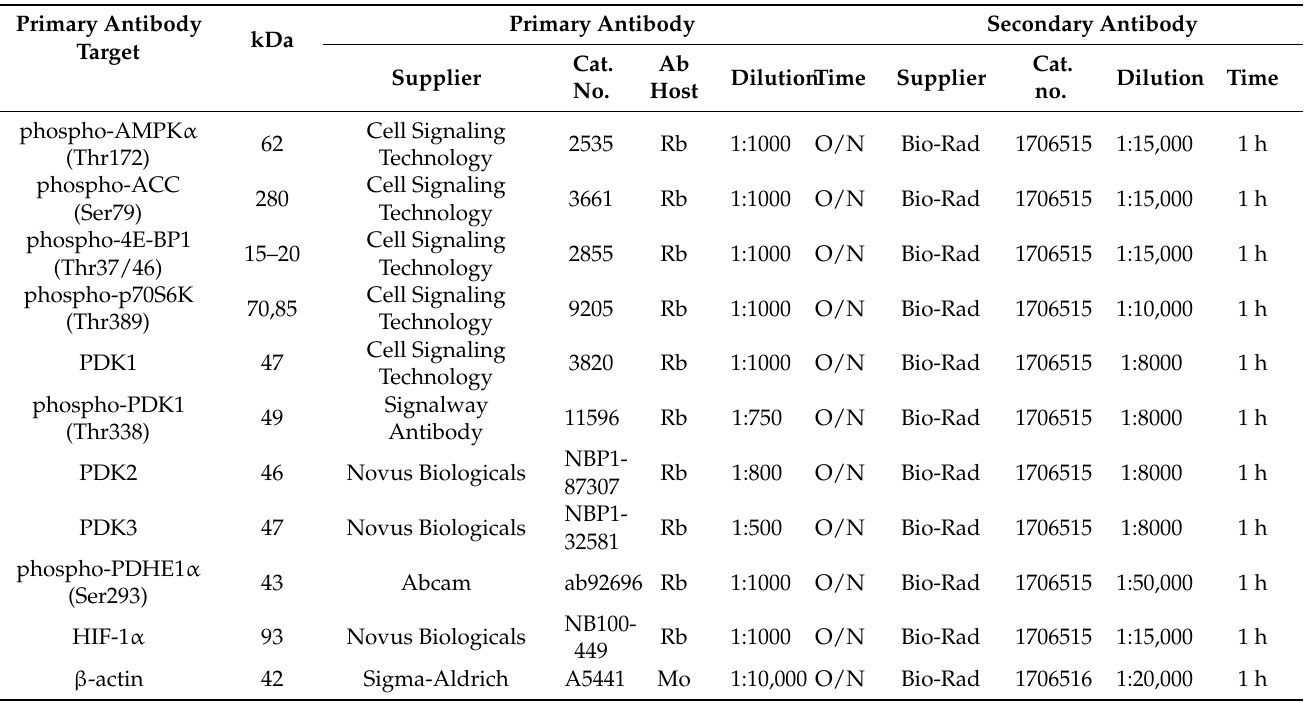
Table 1. Overview of the antibodies used for immunoblotting. Abbreviations: Ab—antibody, Mo—mouse, O/N—overnight, Rb— rabbit. Cell Signaling Technology (Danvers, MA, USA), Novus Biologicals (Centennial, CO, USA), Abcam (Cambridge,